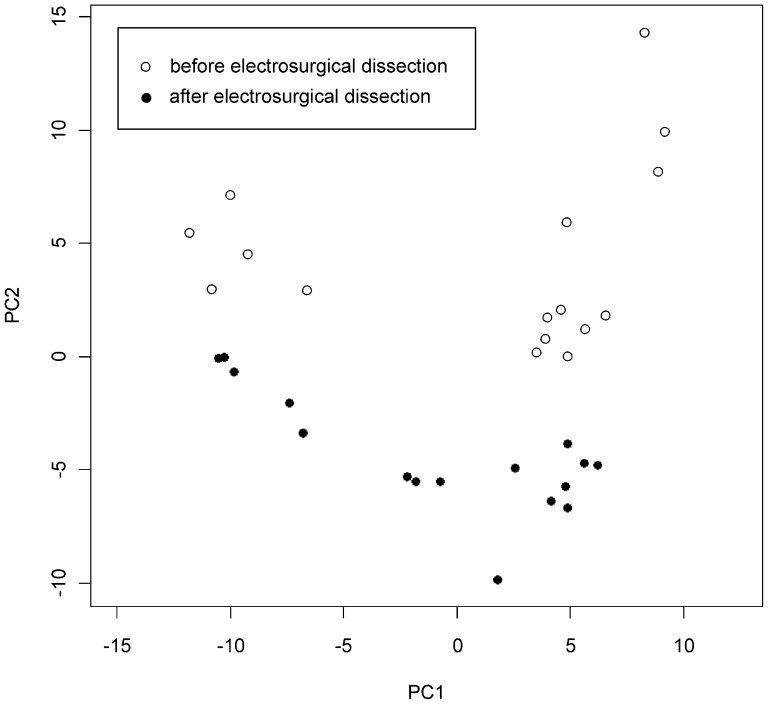
Principal components analysis of the samples of the discovery stage.The first two principal components are plotted. Samples before and after ES are marked with open and filled circles, respectively.